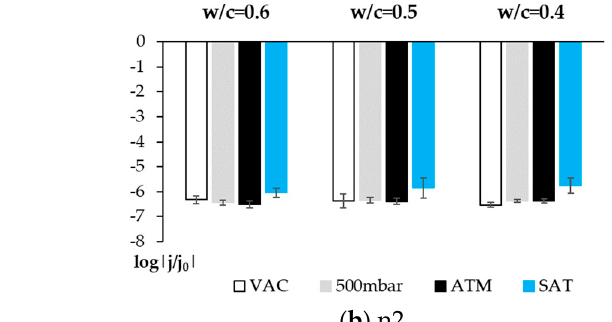
Figure 14. ( a ) Reaction of O 2 reduction in acid/neutral medium. ( b ) Reaction of O 2 reduction in basic medium. S: Stages of the O 2 reduction reaction.